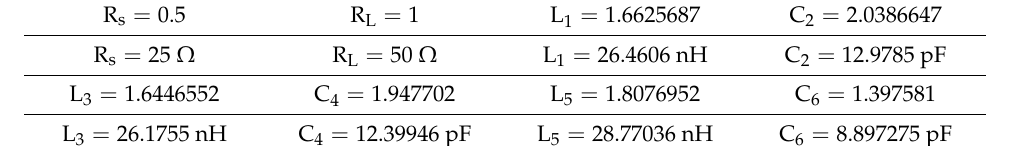
Table 2. Normalized and de-normalized values of passive elements for Pascal N = 6 and Amax = 3 dB [8].